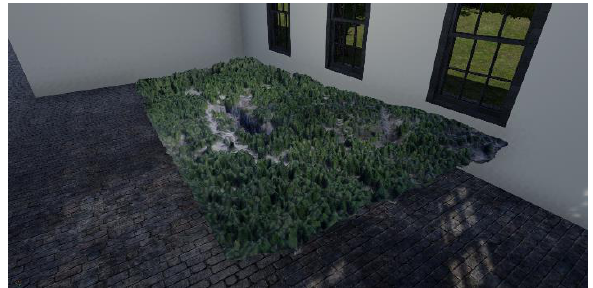
Figure 19. Textured model – “Vlčí jámy” – landscape and mining